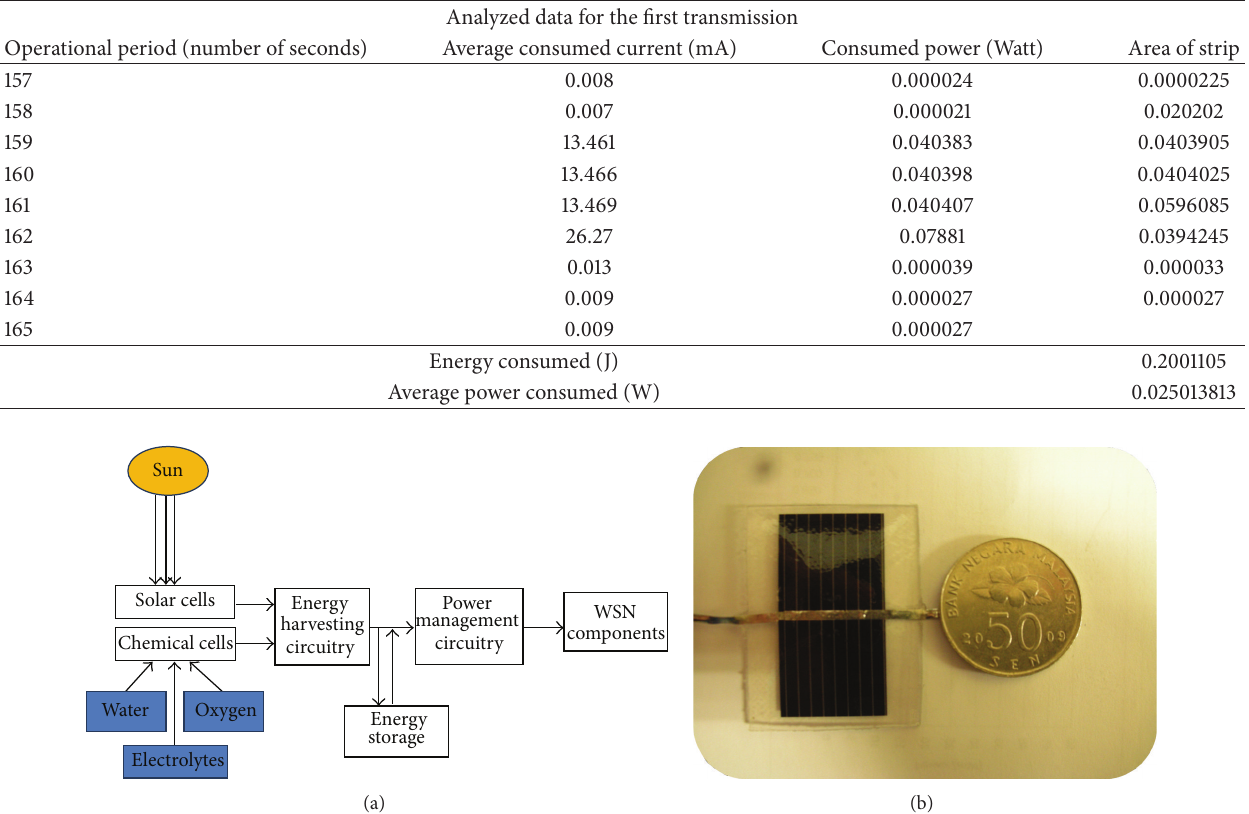
Figure 4: (a) Block diagram to develop a hybrid energy harvester-based complete WSN system. (b) Photograph of the solar cell; its dimension with respect to a Malaysian 50 cent